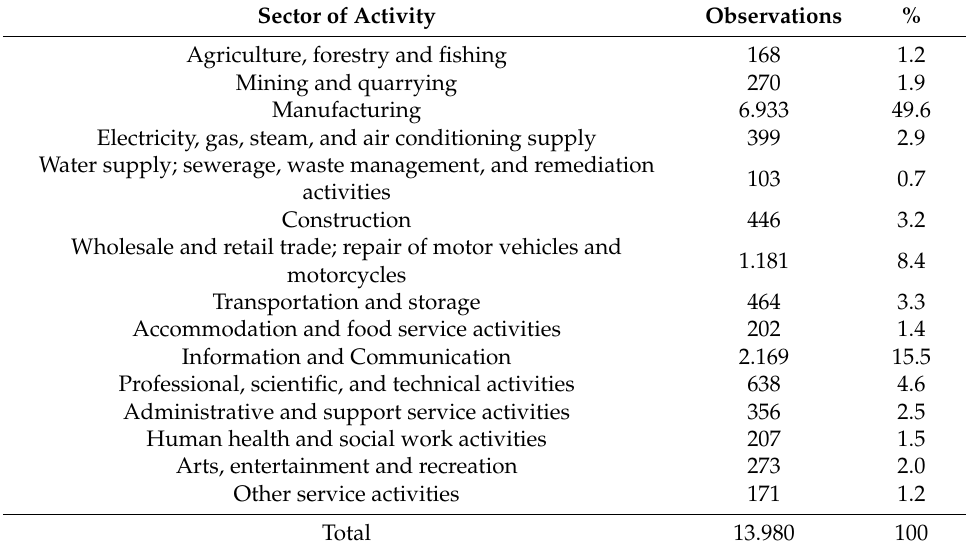
Table 2. Sample composition by